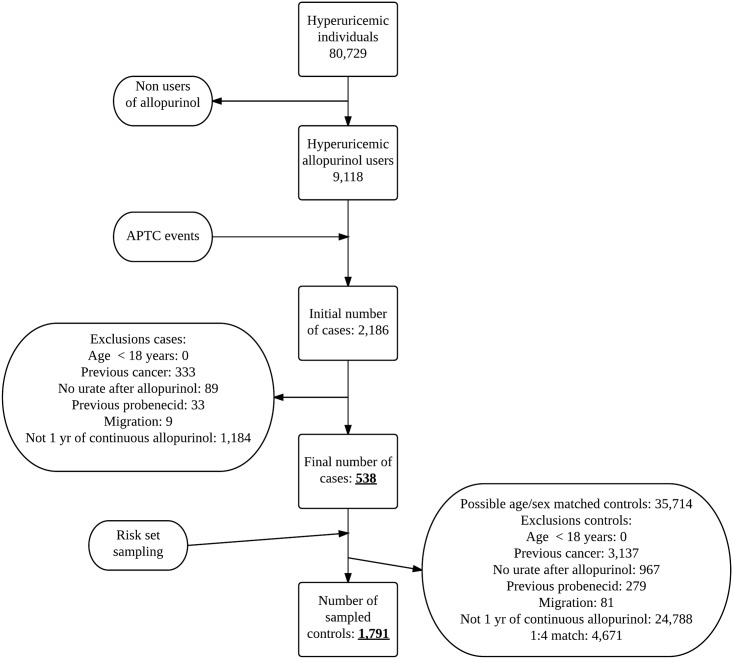
Study flow diagram.